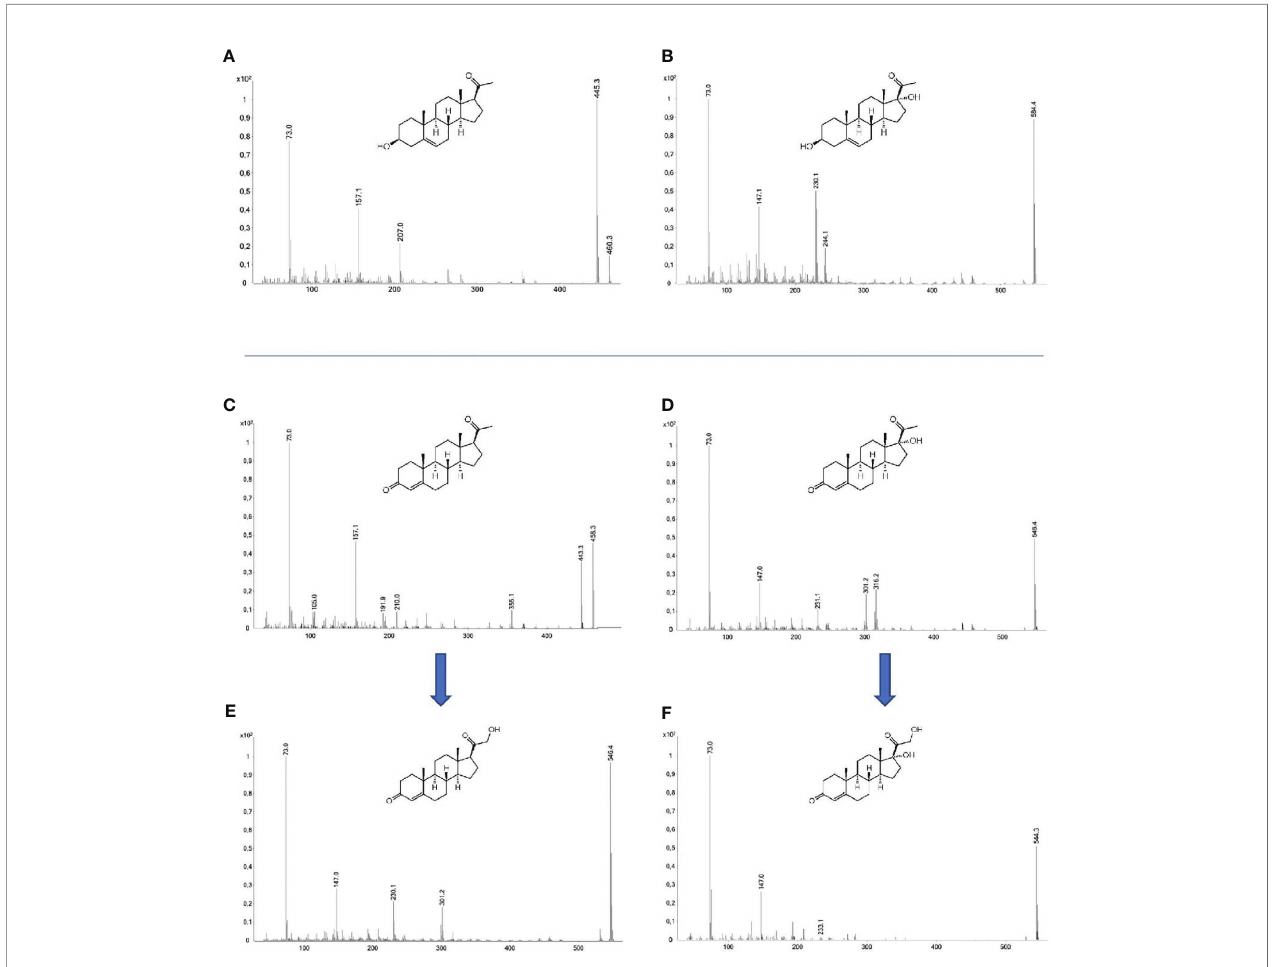
FIGURE 1 | Mass spectra (GC-EI-MS) of the TMS derivatives of pregnenolone (A) , 17 a -hydroxypregnenolone (B) , progesterone (C) , 17 a -hydroxyprogesterone (D) , 11-deoxycorticosterone (E) , 11-deoxycortisol (F) ; abscissa: m/z, ordinate. intensity normalized to the highest